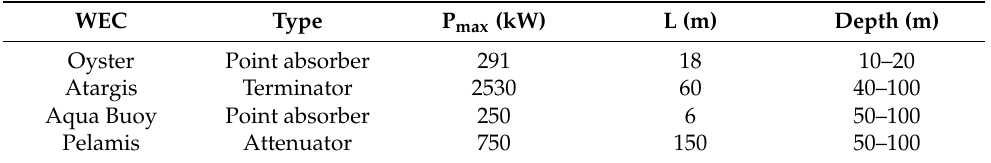
Table 2. Type, maximum electric power, length opposite to the wave, and possible interval of depth for the installation of every analyzed WEC.